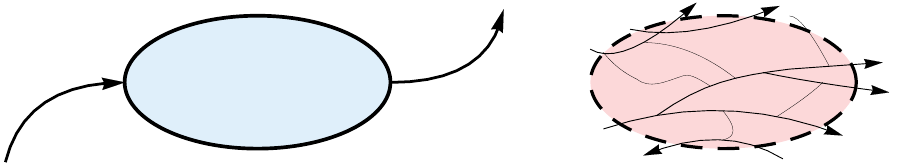
Fig 9. A schematic comparison of blood flow through a large organ (left) and an intermediate size tissue volume (right)